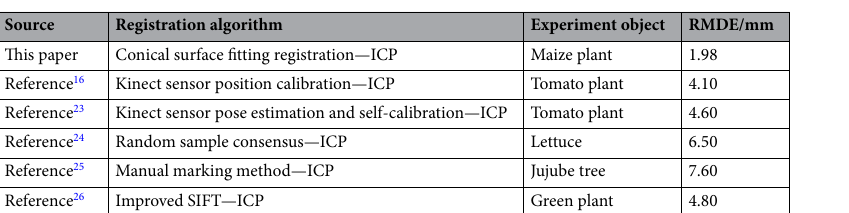
Table 6. Comparison of registration